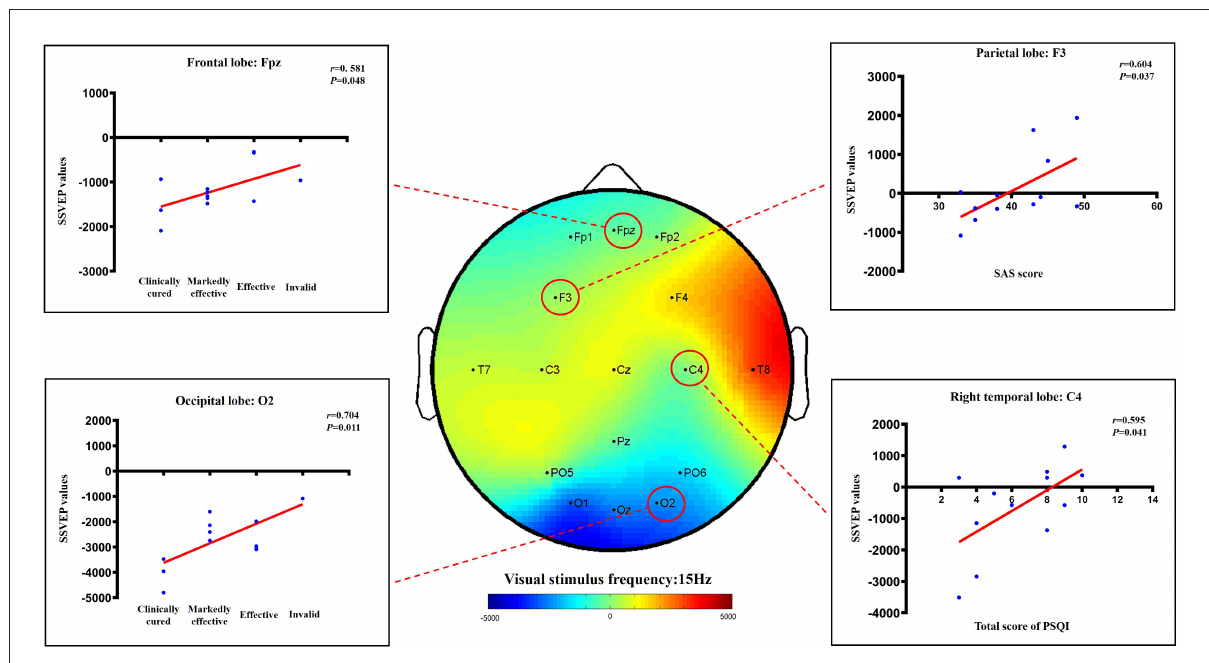
FIGURE10 The correlation between sleep improvement and the change in SSVEP values (active acupuncture group).